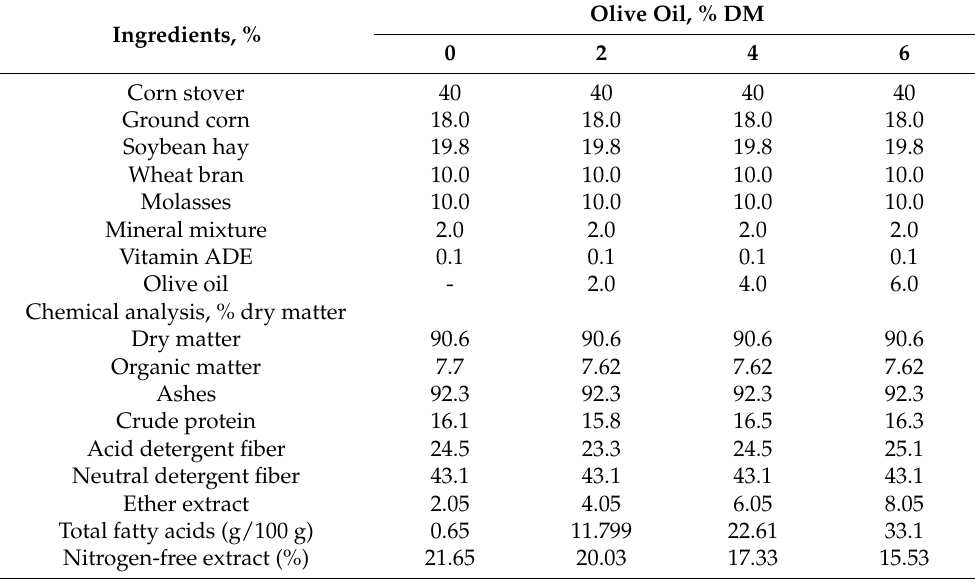
Table 2. Ingredients and chemical composition of dietary treatments fed to growing